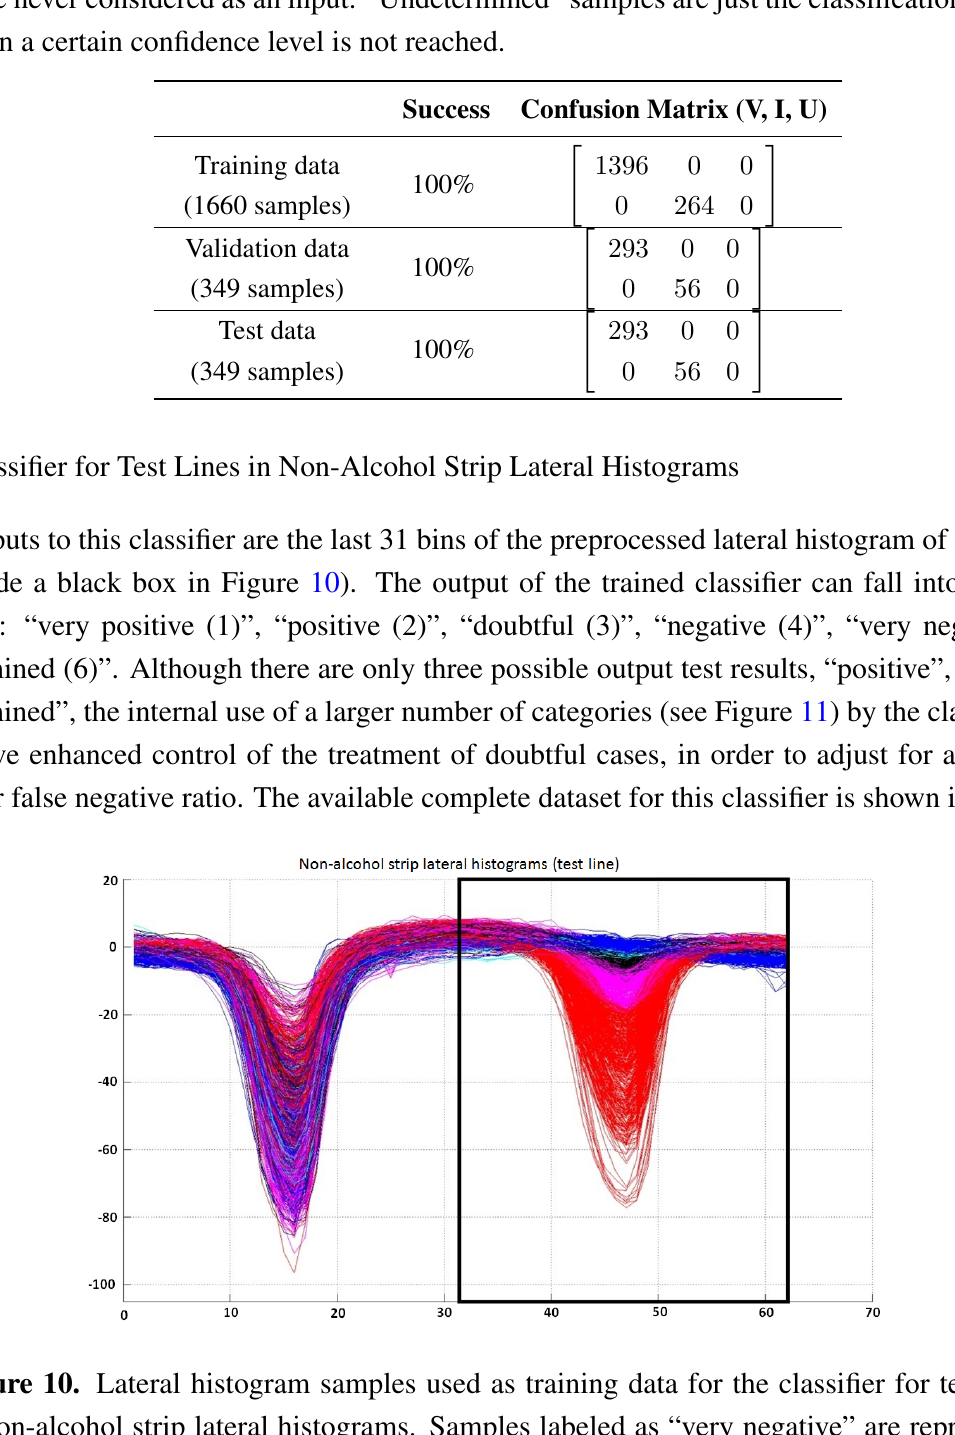
“very negative” or